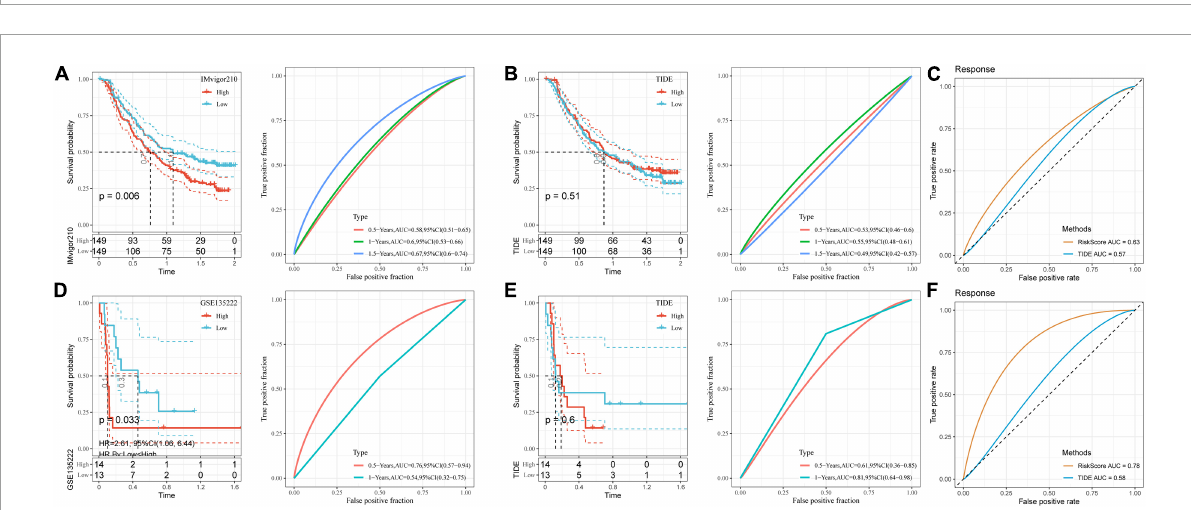
FIGURE8 Performance comparison between risk model and TIDE. (A) K–M curve and ROC curve of DAMPs risk score in IMvigor210 dataset; (B) K–M curve and ROC curve of immunotherapy response predicted by TIDE in IMvigor210 dataset; (C) DAMPs risk score in IMvigor210 dataset and ROC curve of immunotherapy effect predicted by TIDE; (D) K–M curve and ROC curve of DAMPs risk score in GSE135222 dataset; (E) K–M curve and ROC curve of immunotherapy response predicted by TIDE in GSE135222 dataset; (F) DAMPs risk score of GSE135222 dataset and ROC curves of immunotherapy effect predicted by